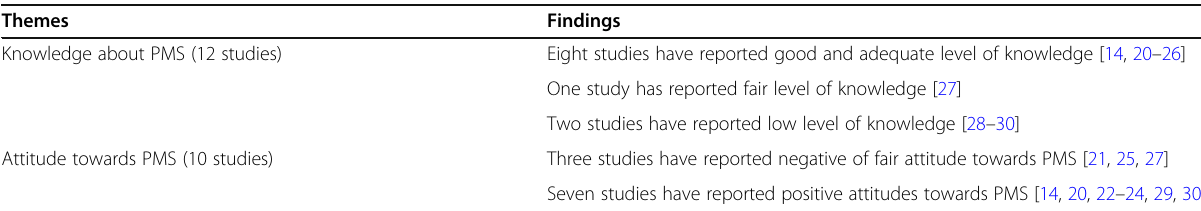
Table 2 Themes from the review on PMS